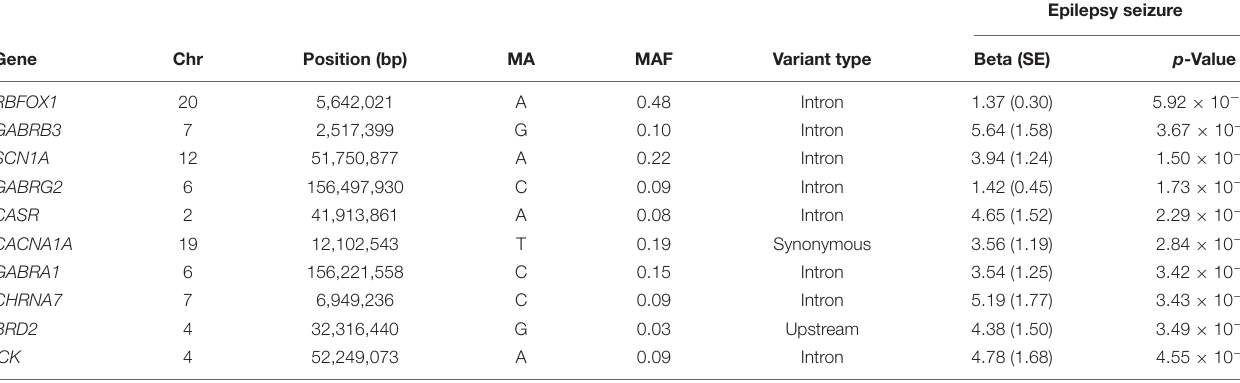
TABLE 1 | Top ten candidate genes based on SNP association results for epileptic seizure in baboons.